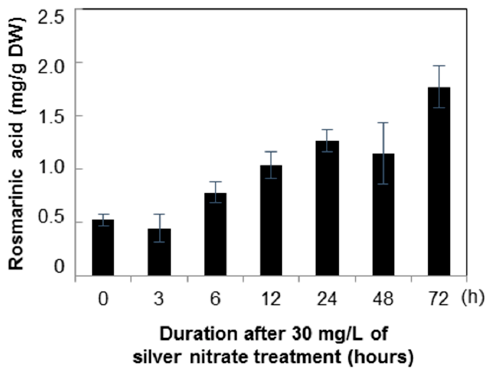
Figure 9. Time course of rosmarinic acid contents in Agastache rugosa callus treated with 30 mg/L silver nitrate. The levels of rosmarinic acid in each sample were analyzed by HPLC. Error bars show standard deviation values.